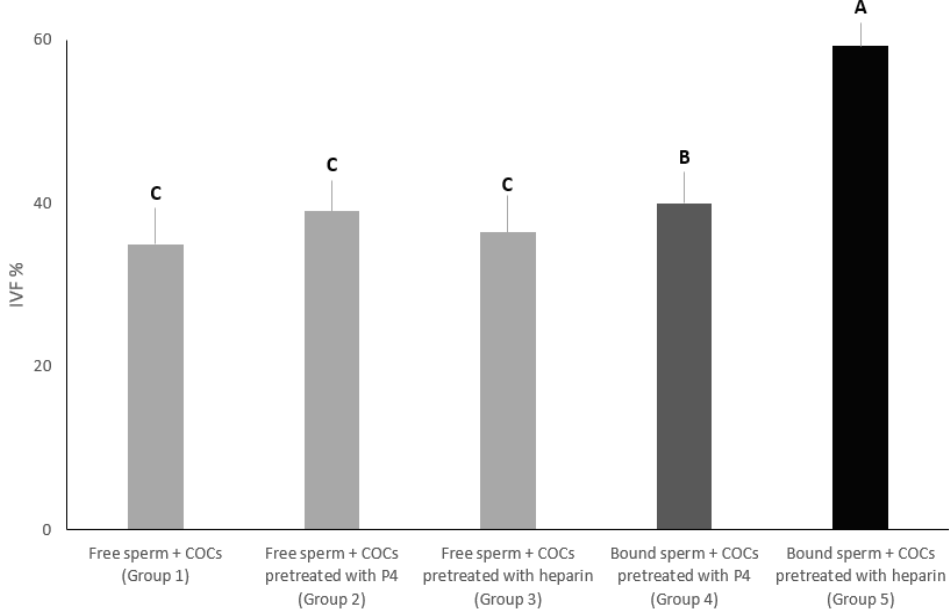
Figure 4. In group 1, mature COCs without any treatments were added to free sperm cells. In groups 2 and 3, mature COCs were added, pre-treated with progesterone at 80 nanomolar and heparin at 40- μ g/mL, to free sperm cells, respectively. In groups 4 and 5, sperm cells were incubated with cell aggregates from the isthmus, and then mature COCs, pre-treated with heparin at 40- μ g/mL or pro- gesterone at 80 nanomolar, respectively. The in-vitro fertilization rate was recorded for all groups. Columns with different letters are significantly different ( p < 0.01). groups. Columns with different letters are significantly different ( p <